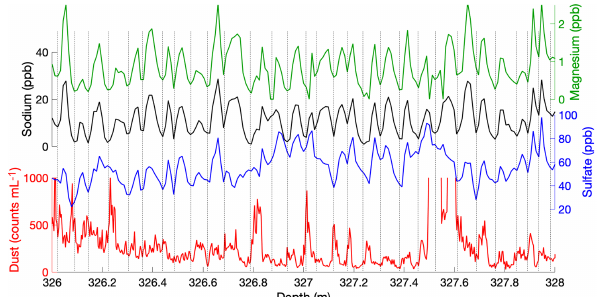
Figure 2. Example of annual layering in a representative segment of SPICEcore. Depicted are magnesium (green) and sodium (black) concentrations showing nearly identical variations and clear annual cyclicity. Sulfate (blue) has consistent but less pronounced layering, and dust (red; 1 micron size bin) has occasionally visible annual layering. Vertical dashed lines show annual pick positions based on the data